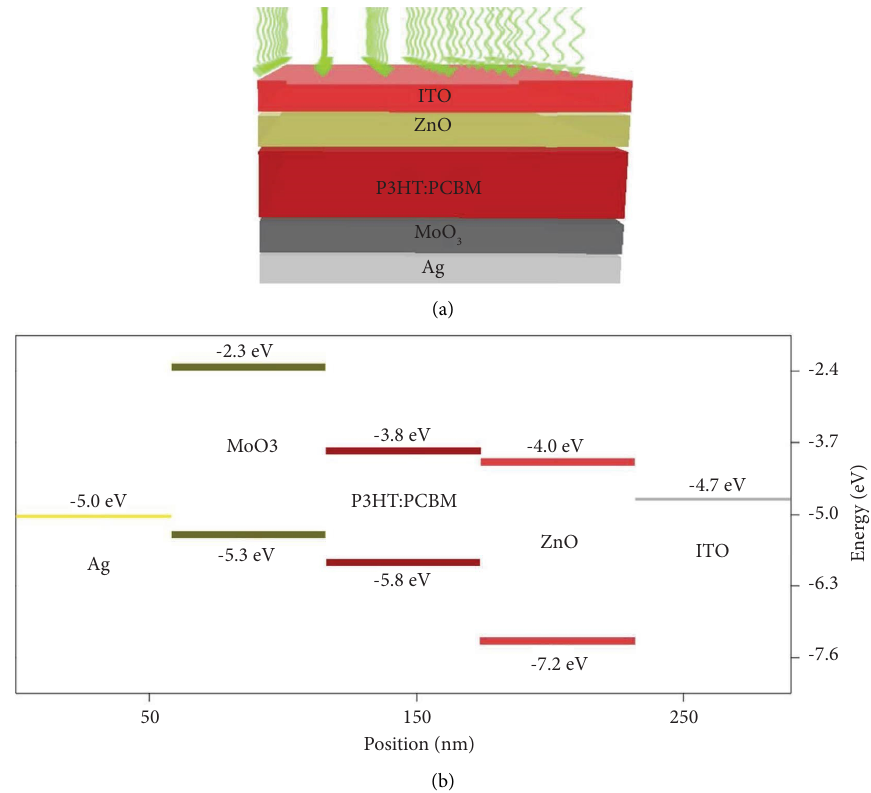
Figure 1: (a) ITO/ZnO/P3HT: PCBM/MoO3/Ag device structure. (b) Te energy level diagram for each components of the